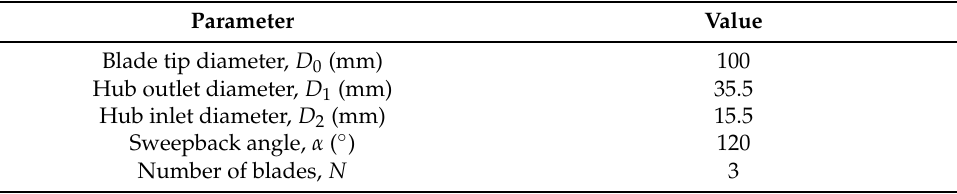
Table 1. Geometric characteristics of the tested three-bladed